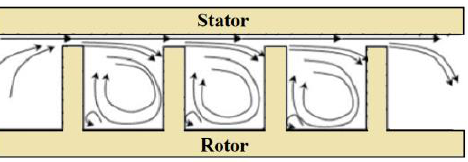
Figure 1. Schematic of a cross‐sectional area of a straight‐through labyrinth seal.